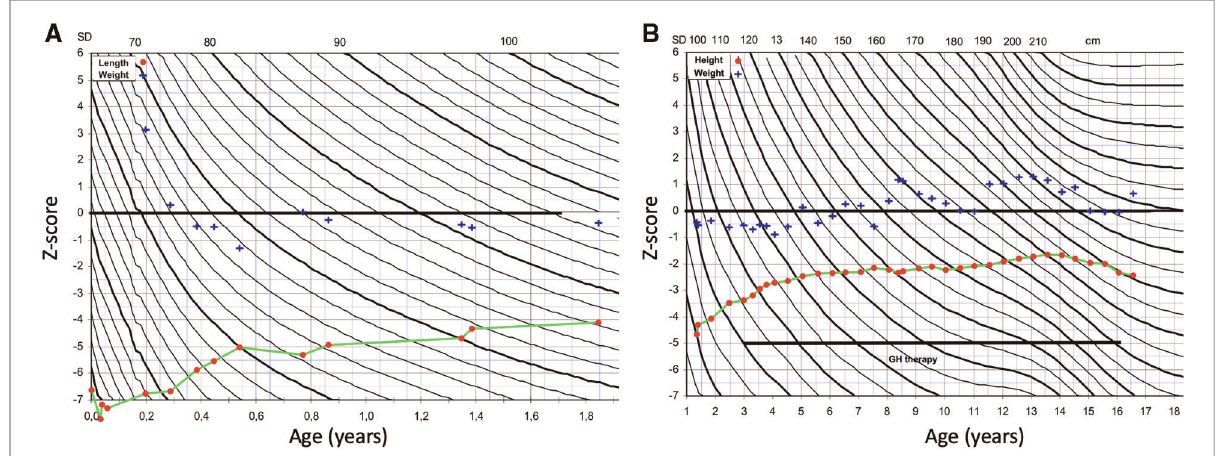
FIGURE 1 Growth charts of the patient. ( A ) Z-score for length (red dot) and weight-for-length (blue cross) at 0 – 2 years of age. ( B ) Z-score for height (red dot) and weight-for-height at 1 – 16 years of age. Growth hormone (GH) therapy was started at 3 years of age.